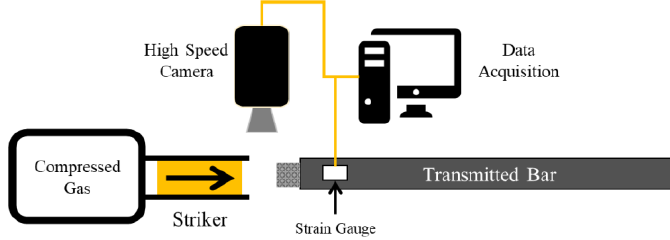
Fig. 3 . Schematic of the direct impact Hopkinson bar (DIHB) setup used to test the TPMS